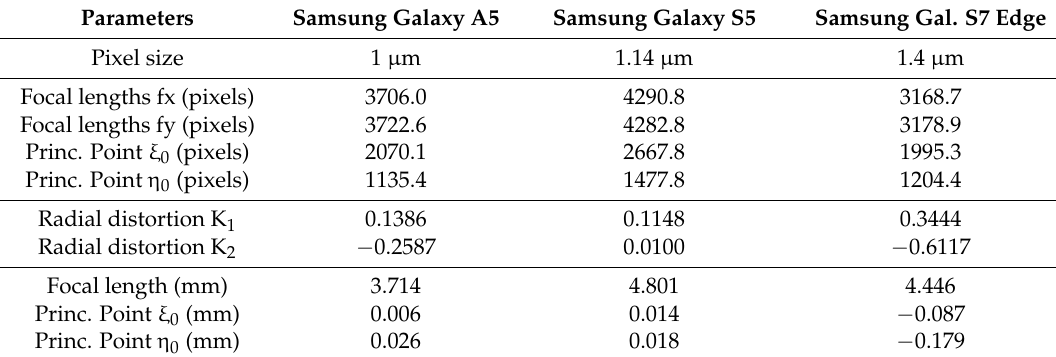
Table 1. Internal calibration parameters.